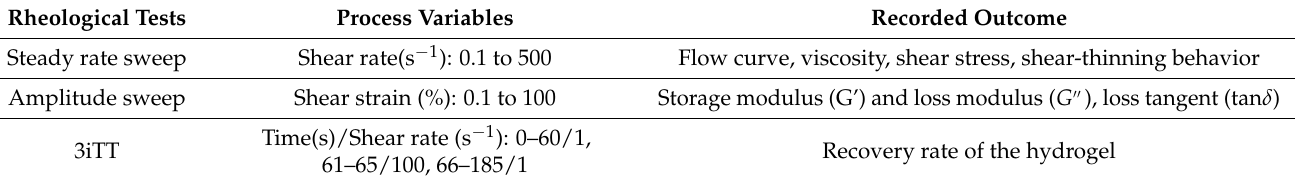
Table 2. An overview of all rheological